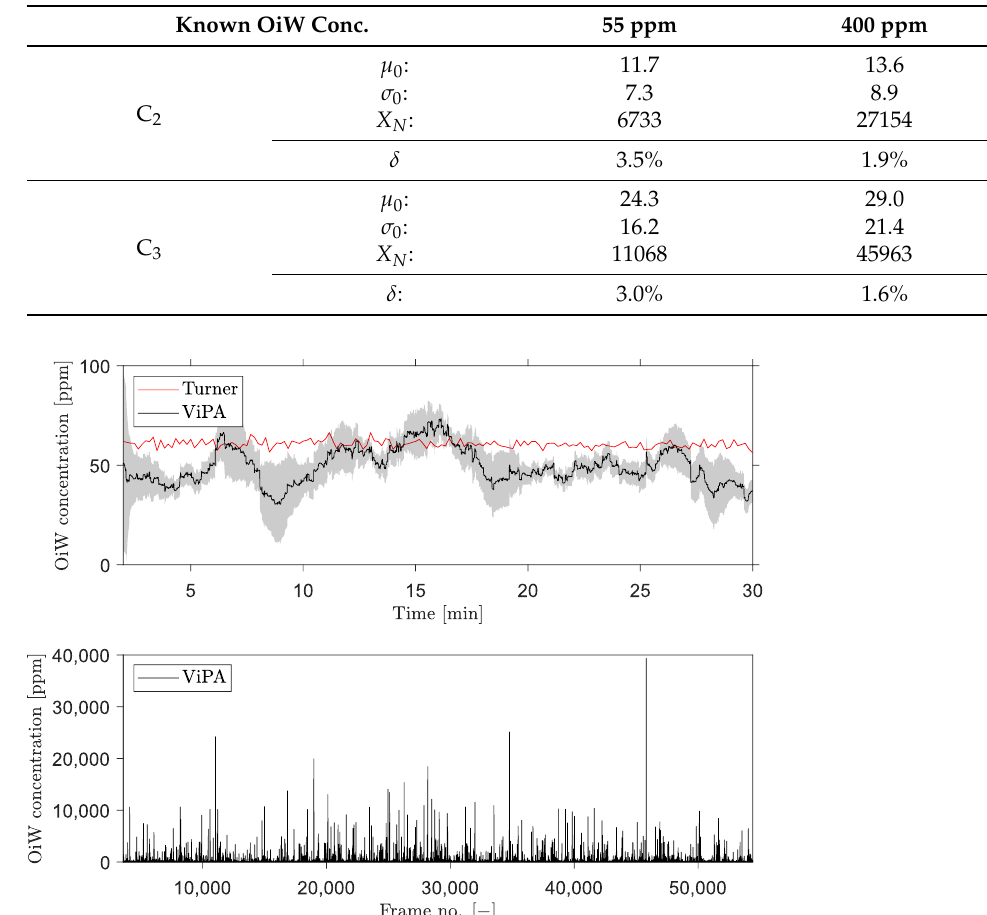
Figure 16. Real-time OiW concentration measurements calculated using a trailing moving average window of 1 min of the post-processed oil volume ratio in each image captured by C 2 . The top graph shows the real-time measurement measured by C 1 and C 2 . A 95% confidence interval of the averaging window is shadowed behind the signal. Bottom graph shows the volume concentration of each frame